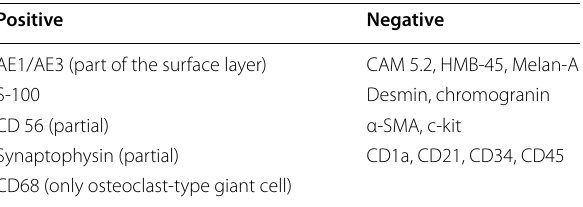
Table 1 The list of immunohistochemical examination for our case